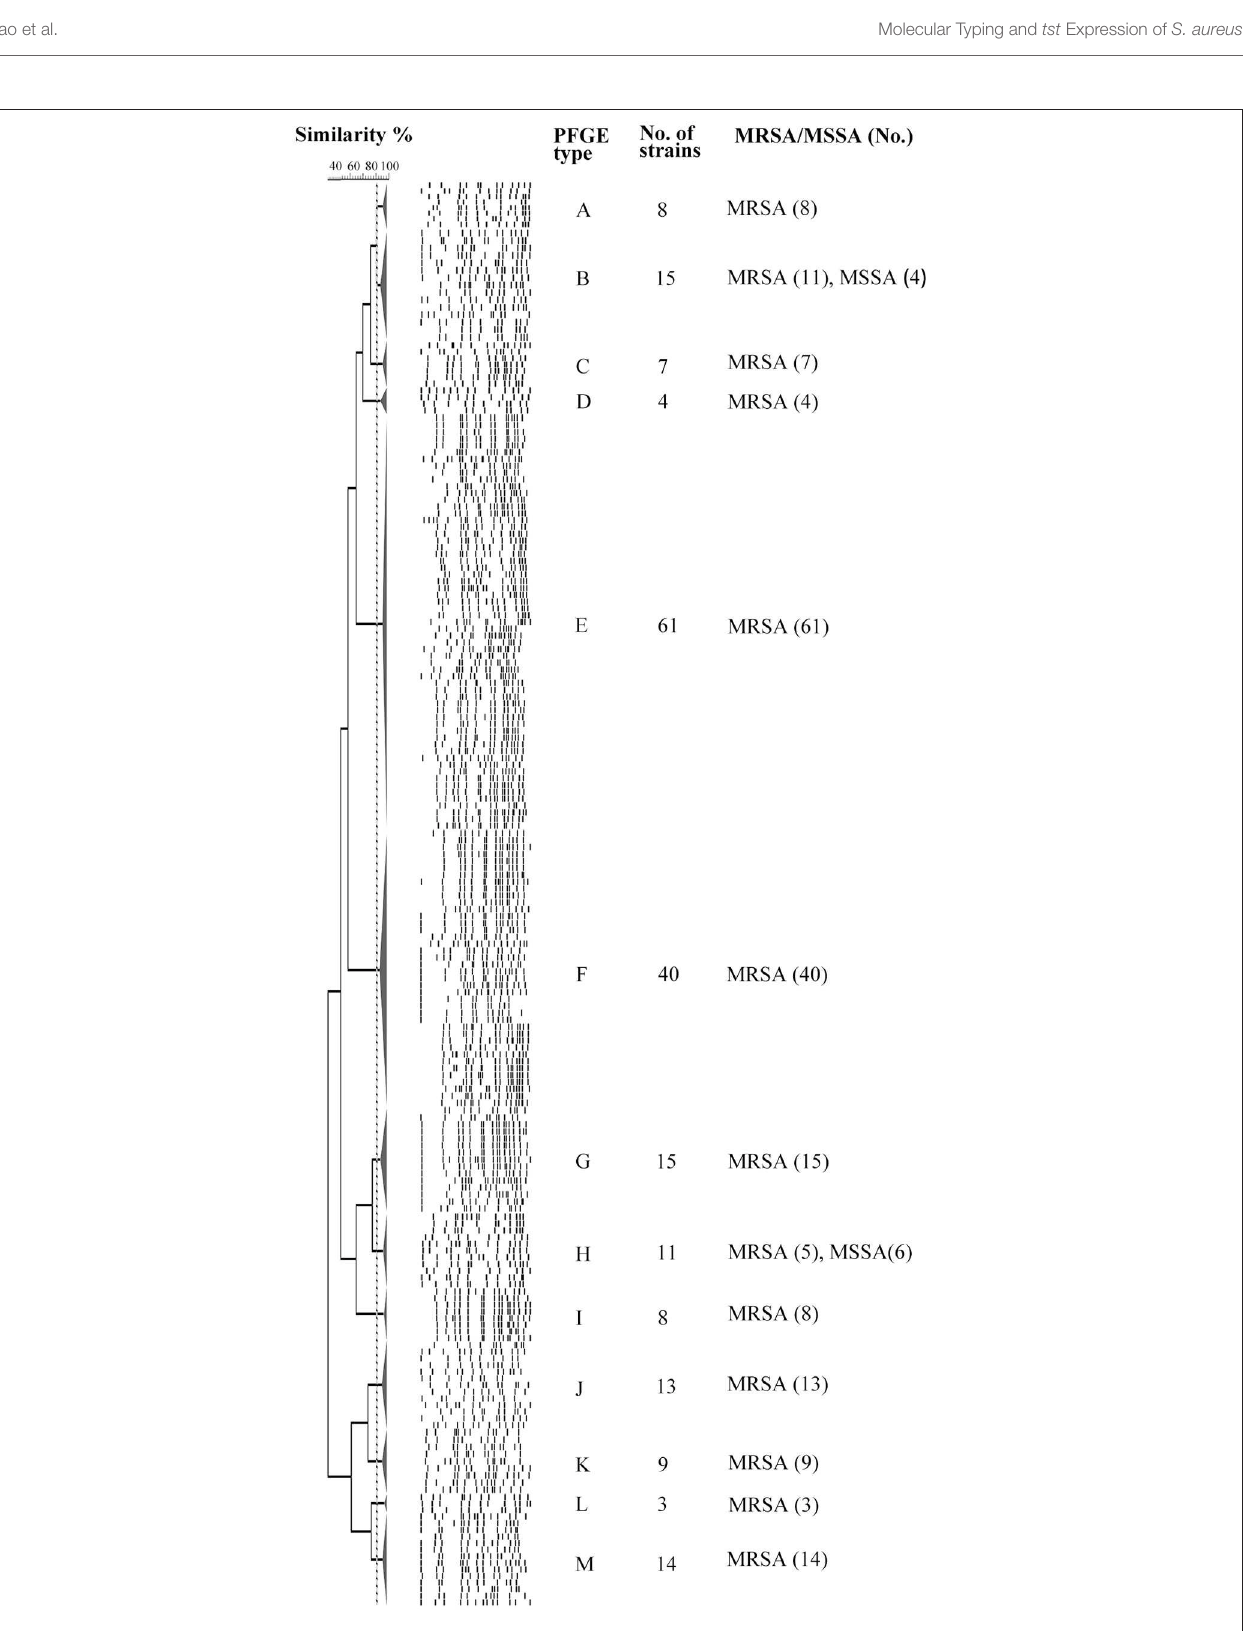
Frontiers in Microbiology |